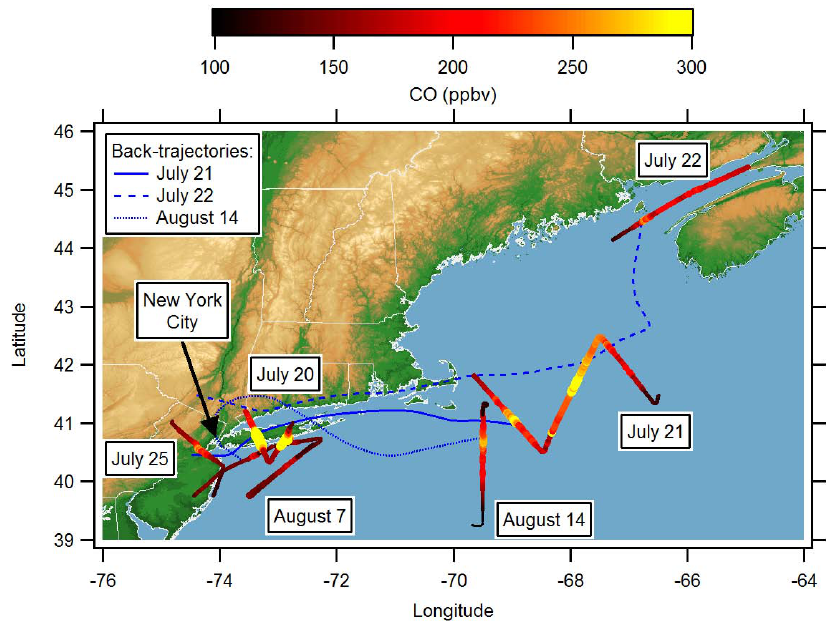
Fig. 3. Portions of the flight tracks from the NOAA WP-3D aircraft on six different days, during which the outflow from New York City was sampled. Back trajectories for three of the sampled plumes are also